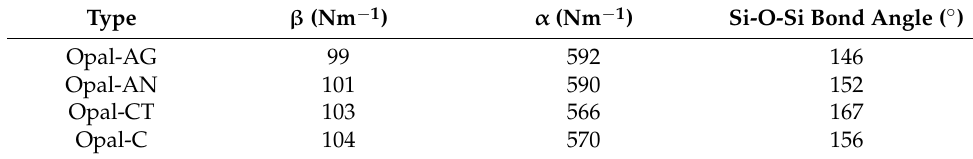
Table 6. Calculation of bond angles based on TO band positions given in Table